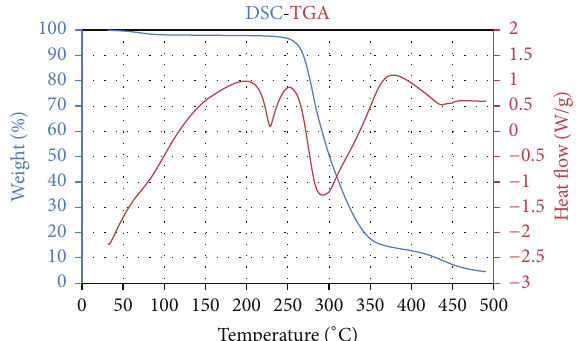
Figure 3: The DSC-TGA thermogram in nitrogen atmosphere for PVA electrospun nanofibers.